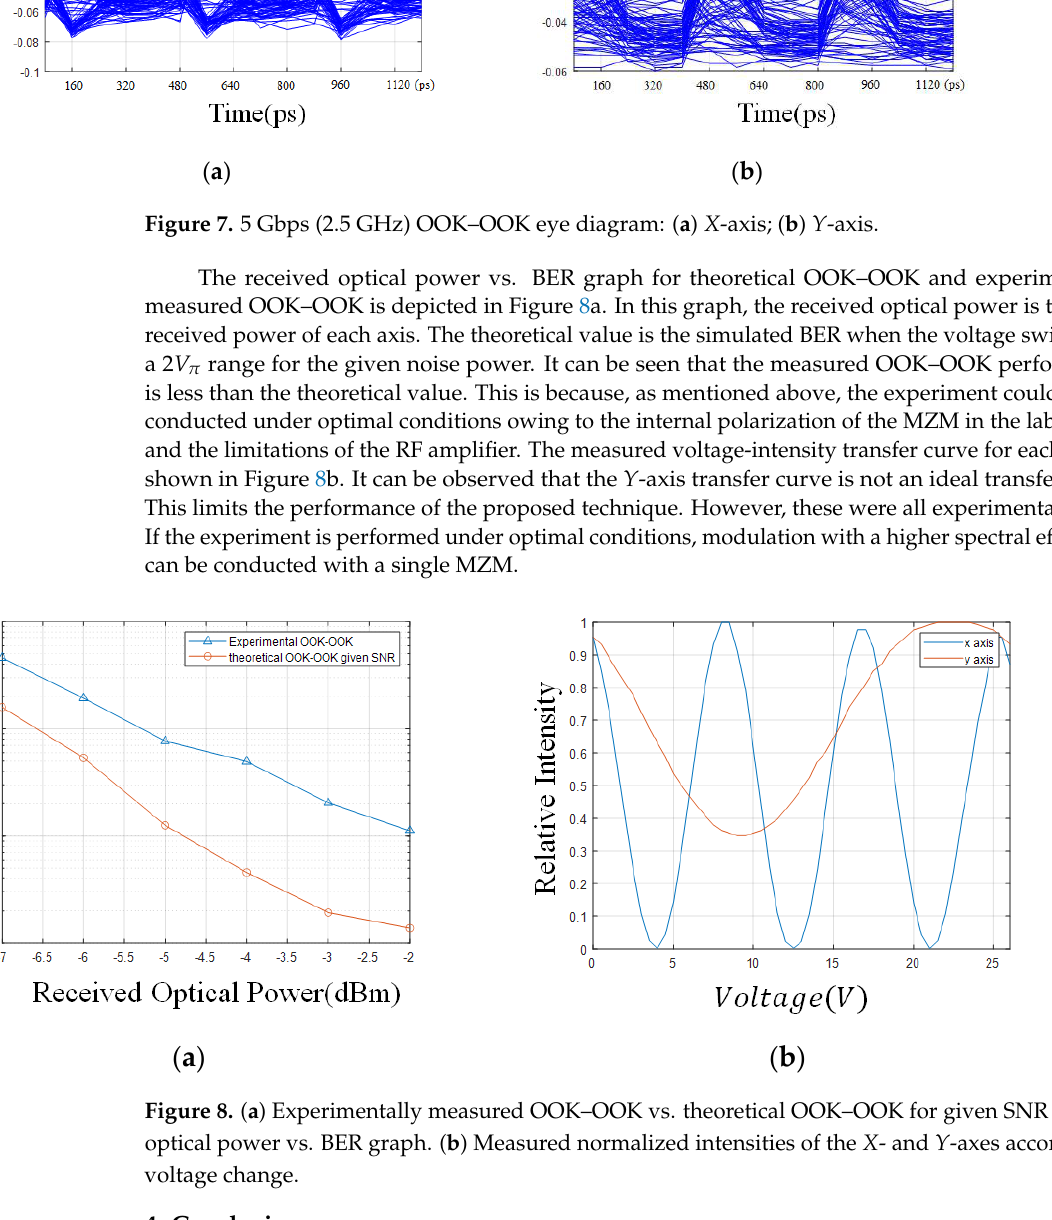
Figure 7. 5 Gbps (2.5 GHz) OOK − OOK eye diagram: ( a ) X − axis; ( b ) Y − axis.